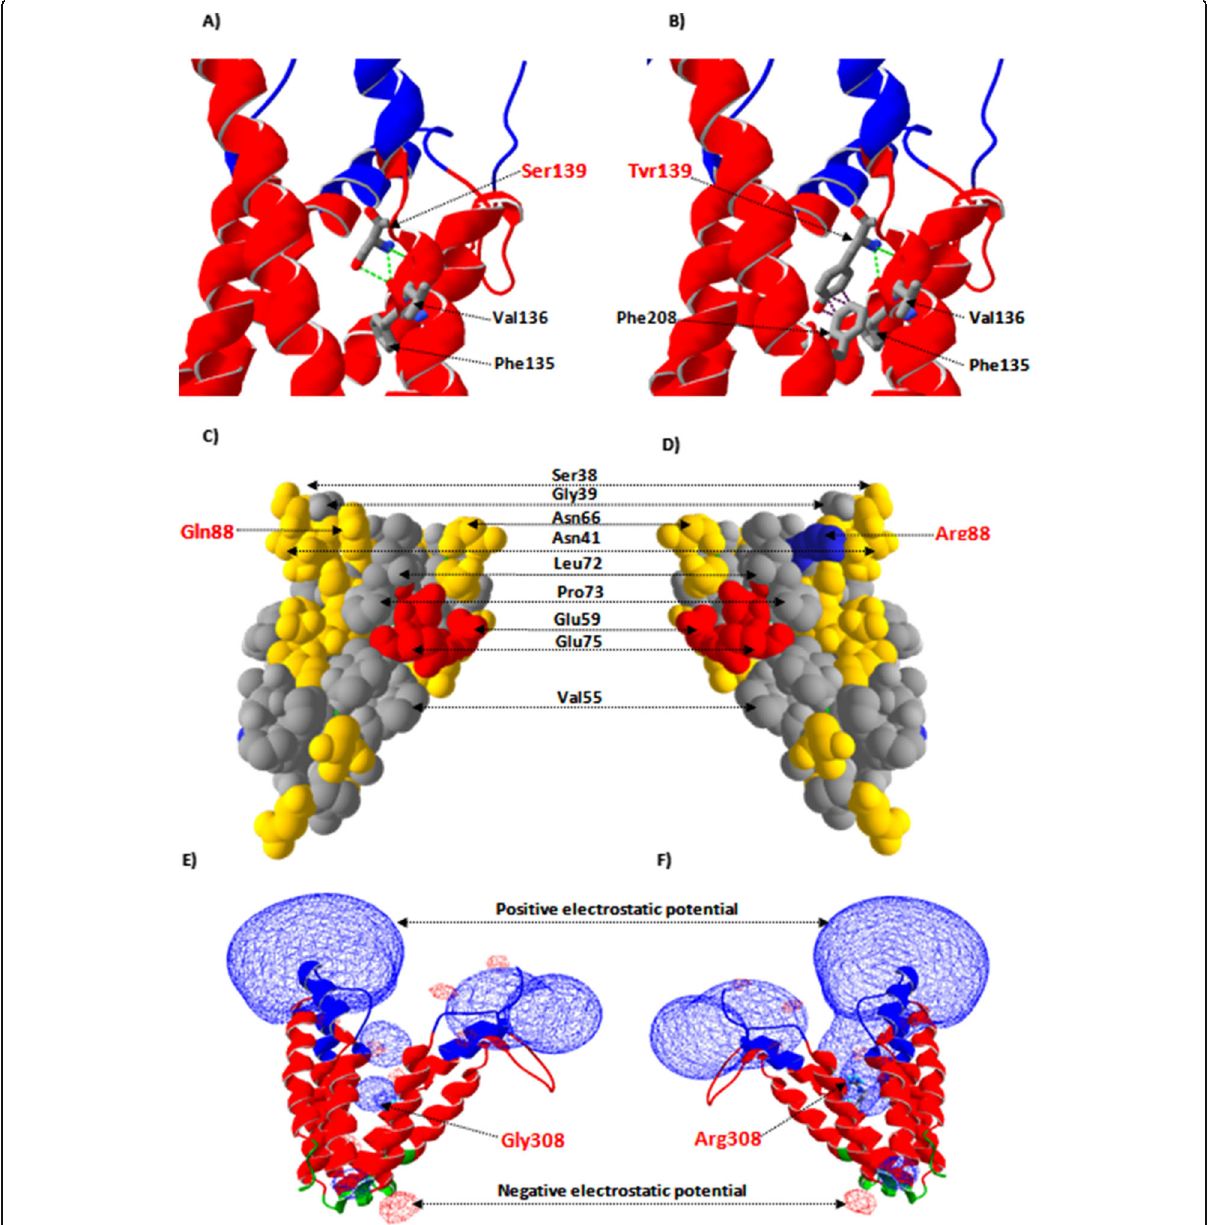
Fig. 3 Modeling structure analysis of the reported three missense mutation Ser139Tyr (upper rows), Gln8Arg (Middel rows) and Gly308Arg (bottom rows). a the backbone of the wild type residue Ser139 form three hydrogen bonds with Phe135 and Val136 (shown as red dotted line), whereas ( b ) the mutated Tyr139 predicted to delete the third hydrogen bond between its side chain and the Val136 backbone and create a steric clash with the Phe208 (shown as black dotted line). c the Gln88 (polar amino acid (yellow)) is surrounded only by polar and nonpolar (grey) residues. Its substitution by Lys88 ( d ) introduced a basic amino acid in a region which tolerate only uncharged residue. For atom representation, acid residues are colored in red, basic in blue, polar in yellow and non-polar in grey. Electrostatic potentials were calculated using ionic strengths corresponding to 0 mM ion concentration and ε P = 4 before ( e ) and after (bf) mutation (Gly308Arg) introduction. The mutated residue, buried in the transmembrane domain, introduce an important positive charge in the core of the